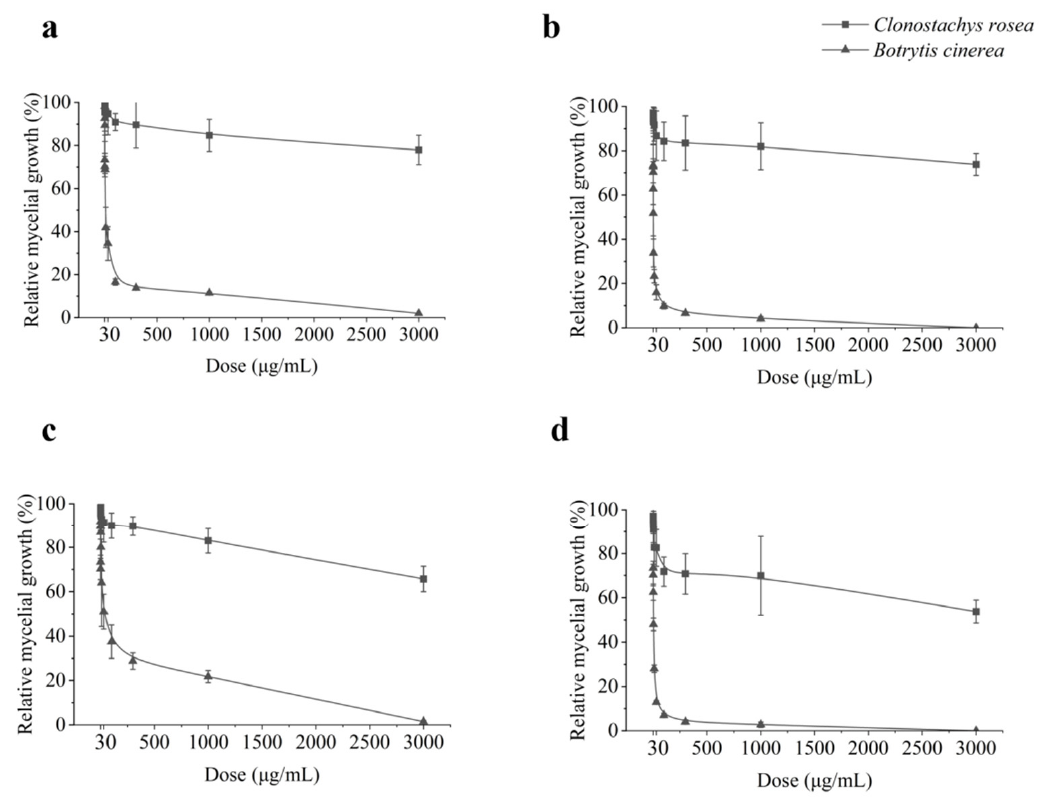
Figure 2. Contrasting in vitro relative growth of Clonostachys rosea and Botrytis cinerea on different concentrations of ( a ) boscalid, ( b ) fluxapyroxad, ( c ) fluopimomide, and ( d ) fluopyram. Mean and standard deviation from the average of eight C. rosea isolates (isolates JLB-7-1, 67-1, SYP-4-2, SHW-1-1, YJS-3-2, GS6-1, NHH-48-2, and BD-2-1) and two B. cinerea isolates (YN80 and YN81) were collected. Table 1. Fungicide sensitivities of the Clonostachys rosea and Botrytis cinerea isolates to carbendazim, tebuconazole, pyraclostrobin, boscalid, fluxapyroxad, fluopimomide, and fluopyram.